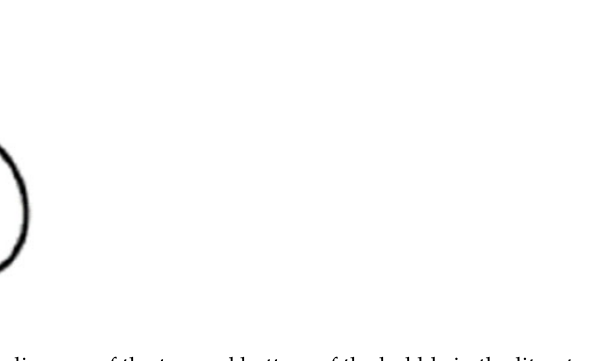
Figure 3. Schematic diagram of the top and bottom of the bubble in the literature.